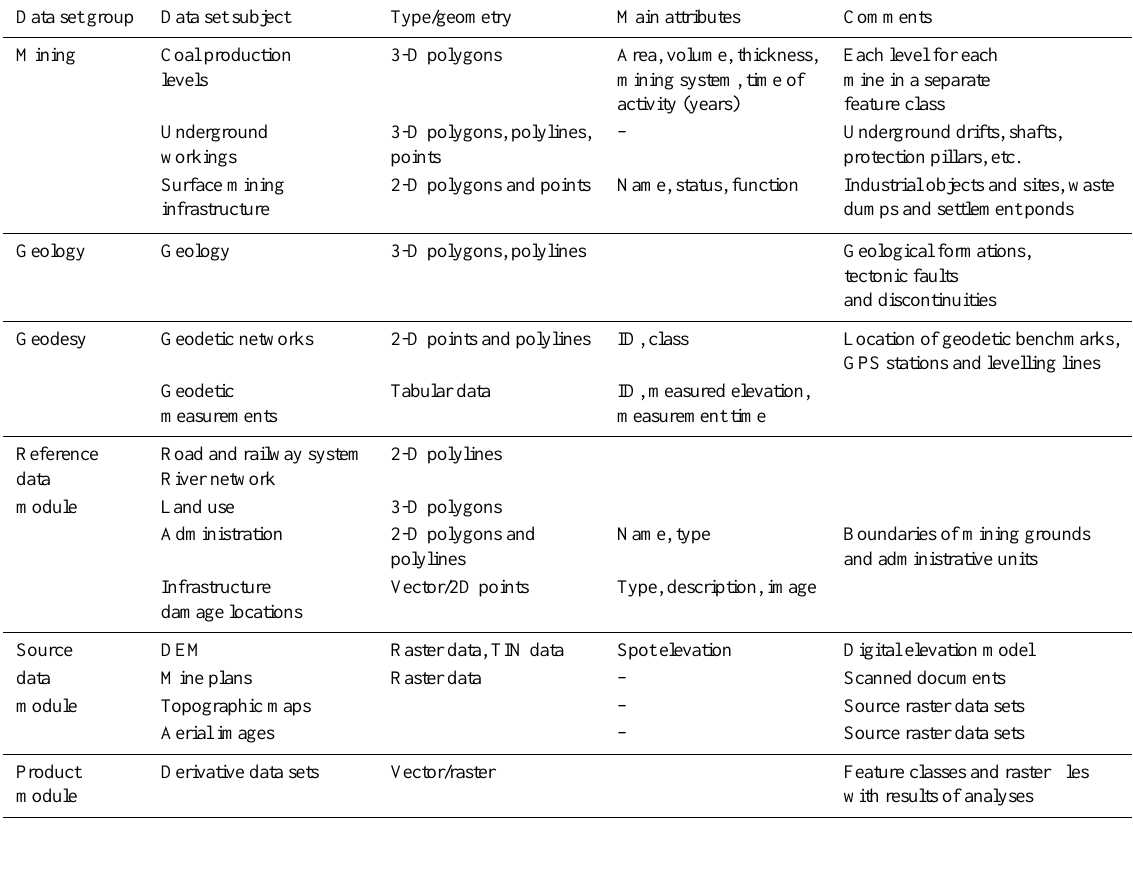
Table 1. The general structure of the DIS database. Data set group